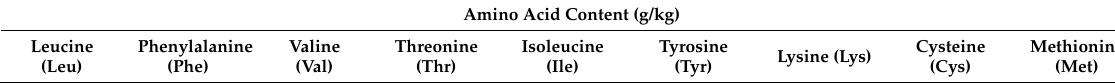
Table 2. Amino acid contents of wild soybean protein